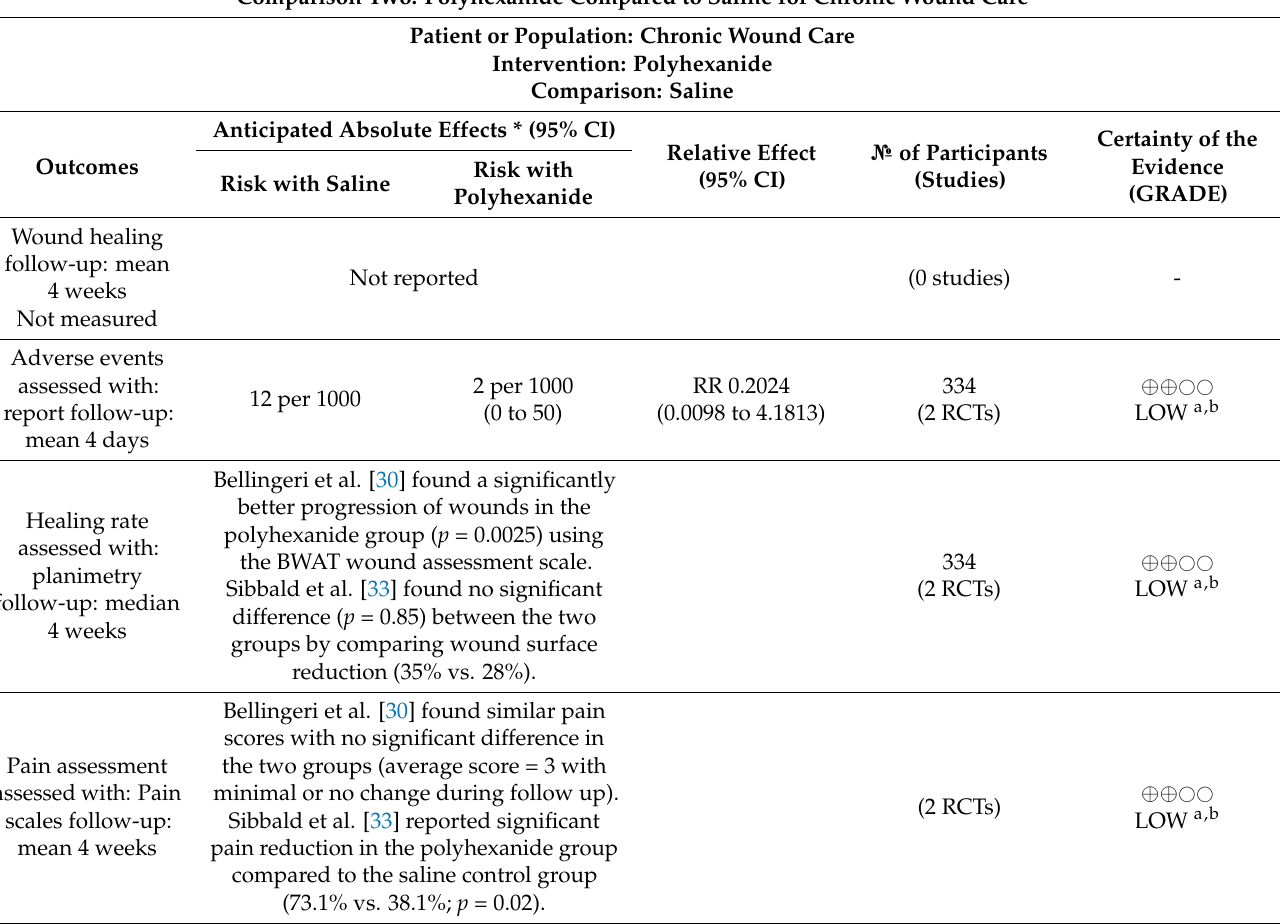
Table 3. Summary of findings table with comparison between polyhexanide and saline solution in chronic wound